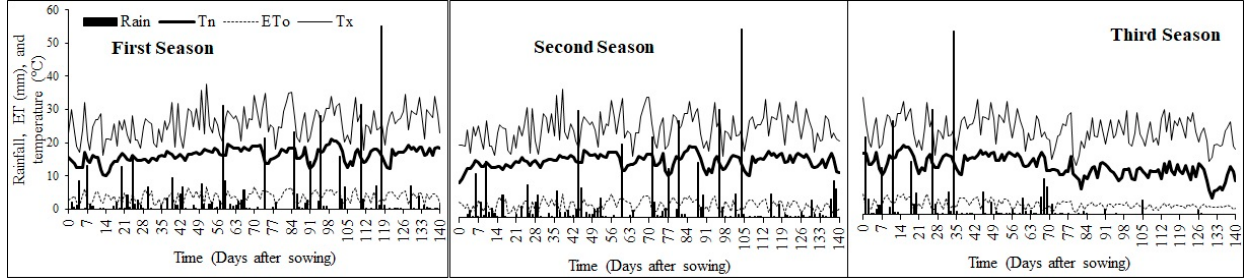
Figure 1. Daily rainfall (rain), reference evapotranspiration (ET0), minimum (Tn) and maximum temperatures at Ukulinga experimental site during three sorghum planting seasons.